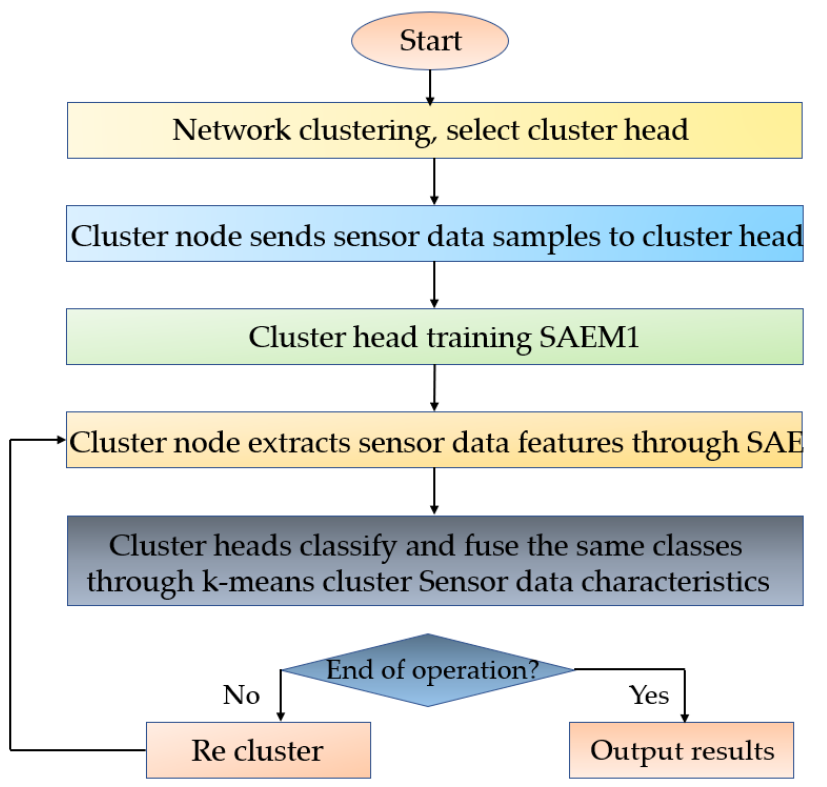
Figure 5. Wireless sensor machine learning SAEMDA1 algorithm flow.